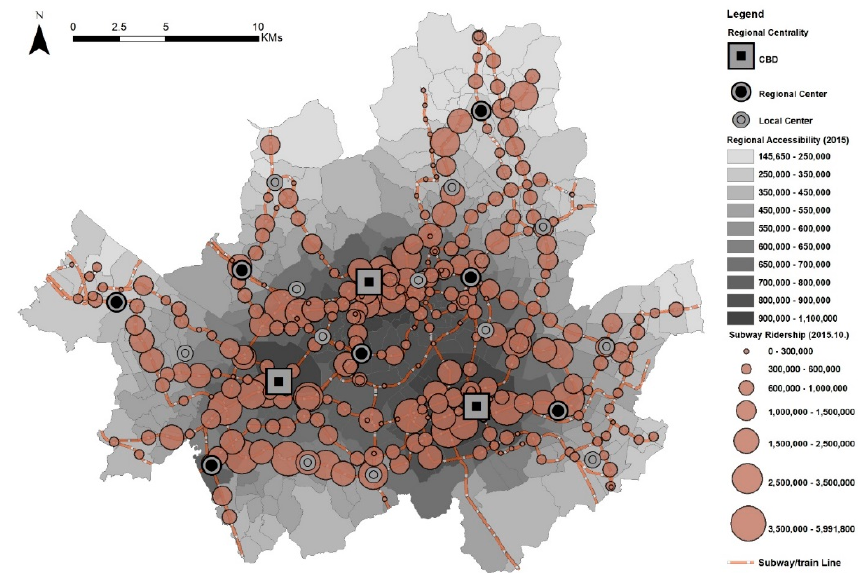
Figure 4. Central places in 2014 [54], regional job accessibility in 2015 (authors’ calculation), and total subway ridership in October 2015 (2015 subway ridership data). Specifically, the log-transformed daily total number of passengers boarding and